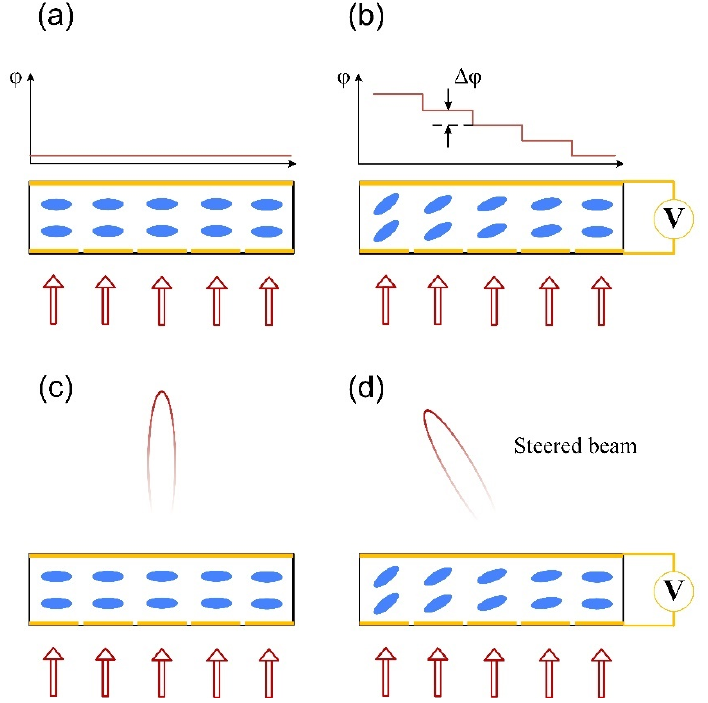
Figure 5. The schematic diagram of the LC-OPA. The phase retardation distribution ( a ) before and ( b ) after applying voltage. The far-field beam ( c ) before and ( d ) after applying voltage.